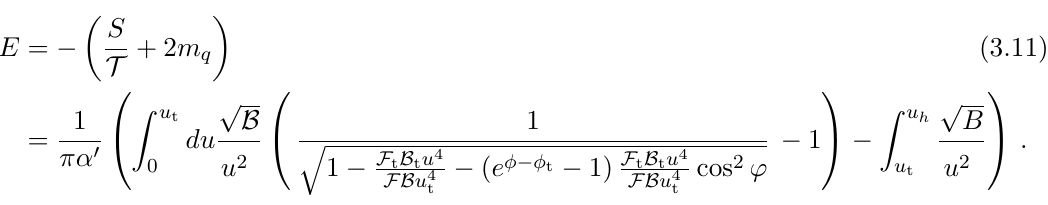
Figure 10 . The binding energy of the q (cid:22) q -pair aligned parallel (left) and perpendicular (right) to the anisotropic z -direction for di(cid:11)erent values of the deformation parameter a . We can again see that the screening distance shrinks which comes together with higher values of E ( L ). We can also see that the e(cid:11)ect of a is much smaller for the perpendicular than for the parallel orientation, too. The (cid:12)nite value for the binding energy of a q (cid:22) q -pair in our anisotropic background is then given